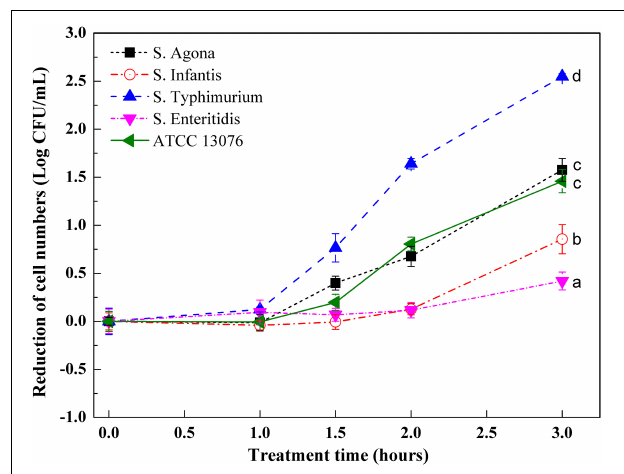
FIGURE 1 | The variation of cell numbers of five Salmonella strains when exposed to acidic stress. Each symbol indicates the mean ± standard deviation of five independent experiments ( n = 5). Different lowercase letters at treatment of 3 h indicated significant difference ( p < 0.05).